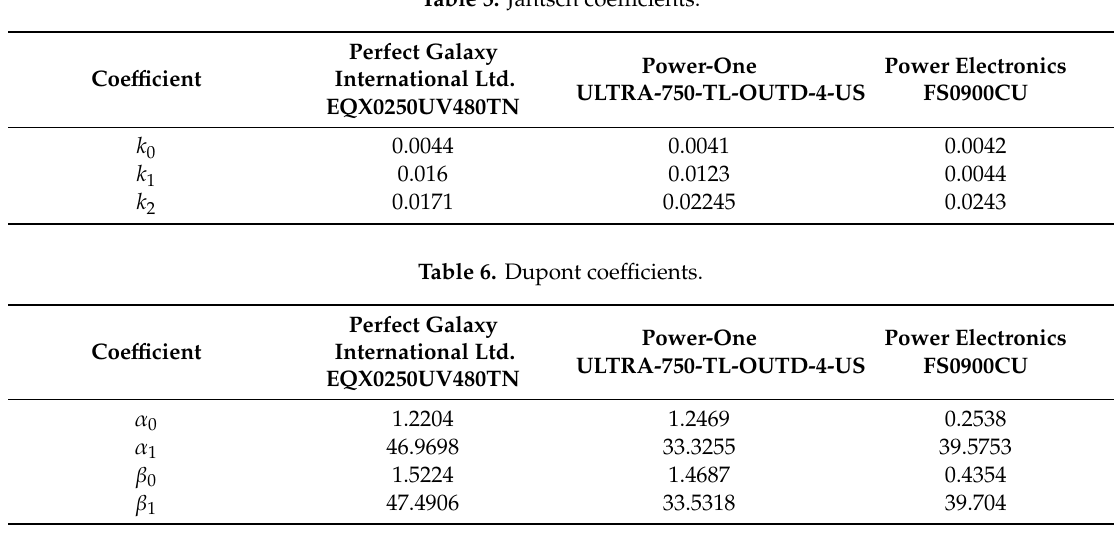
Table 5. Jantsch coe ffi cients.